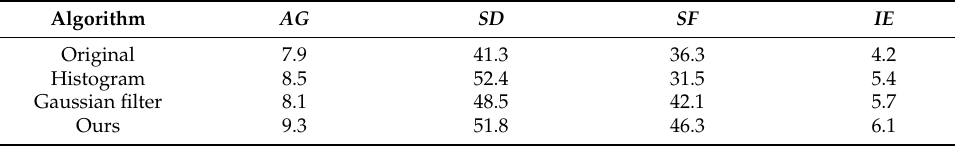
Table 4. Cloud shielded coastline image